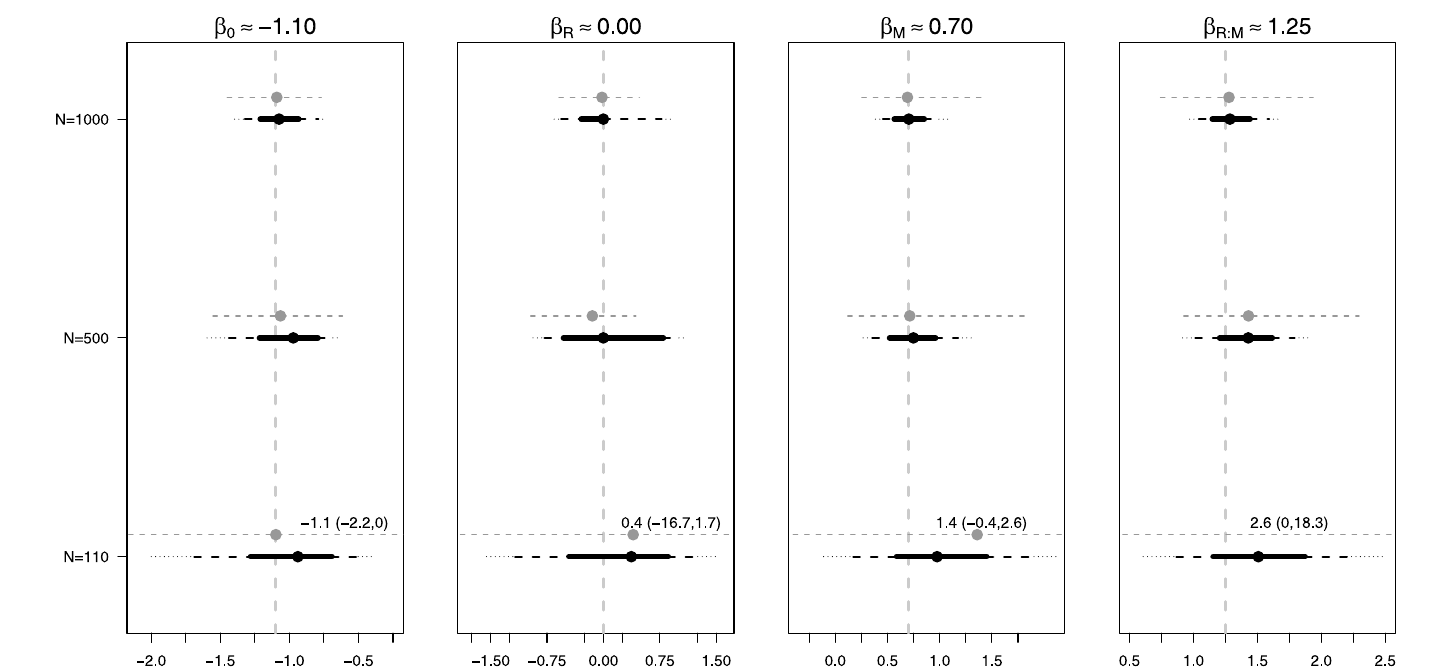
Fig 6. Estimated posterior mean for coefficients using BMA (black) with 20%, 50% and 95% credible intervals. Grey represents distribution of parameters from standard GLM with 95% range of estimates.